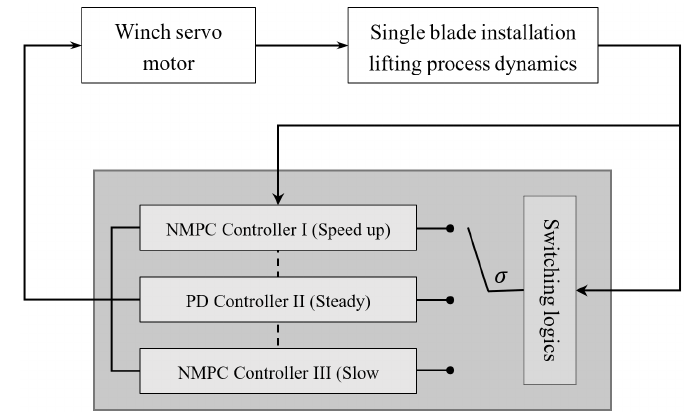
Figure 9. Block diagram of the hybrid control